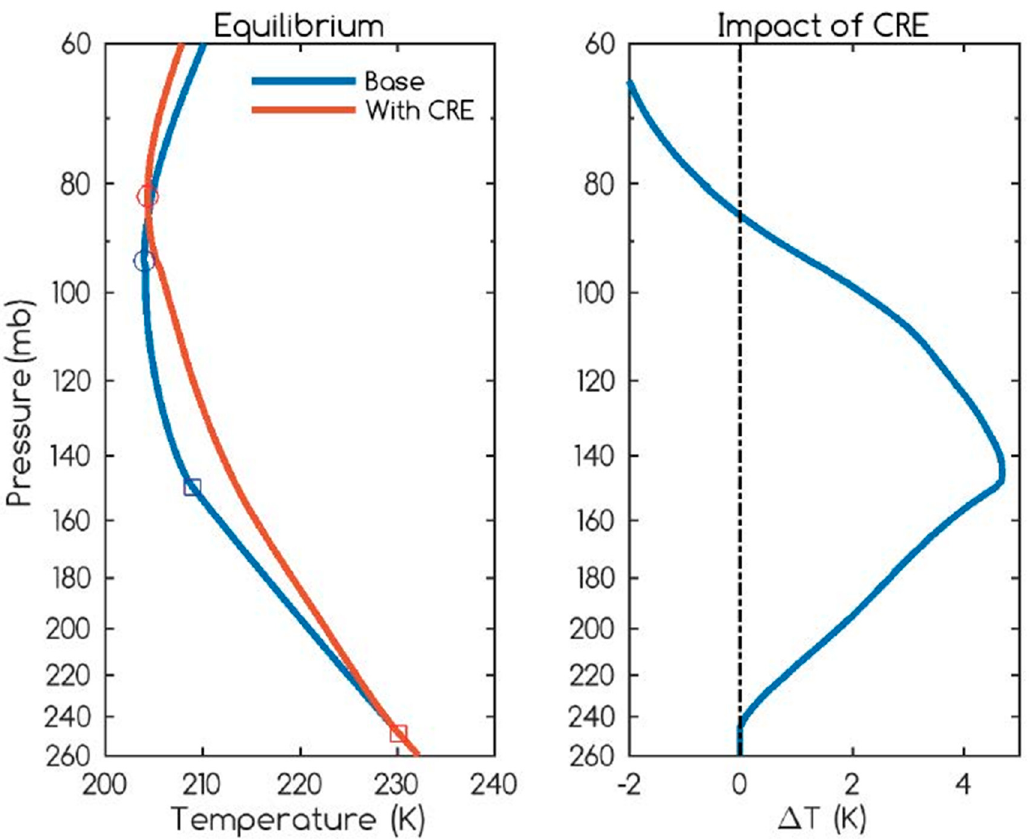
Figure 6. As in Figure 5 but over the western Pacific.